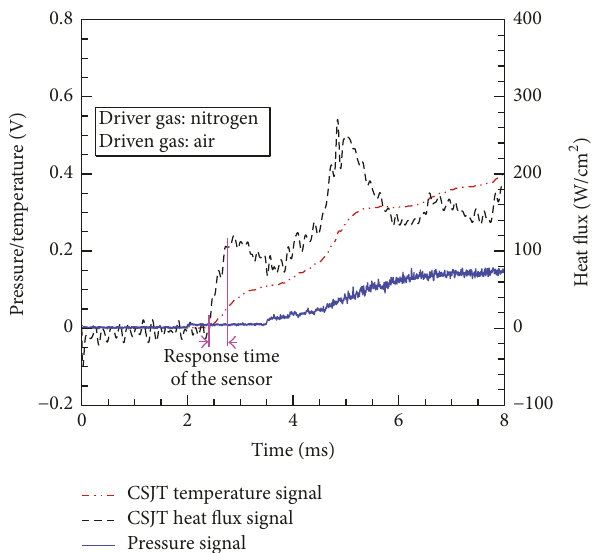
Figure 15: Temperature and heat flux variation for the end flange mounting of shock tube.